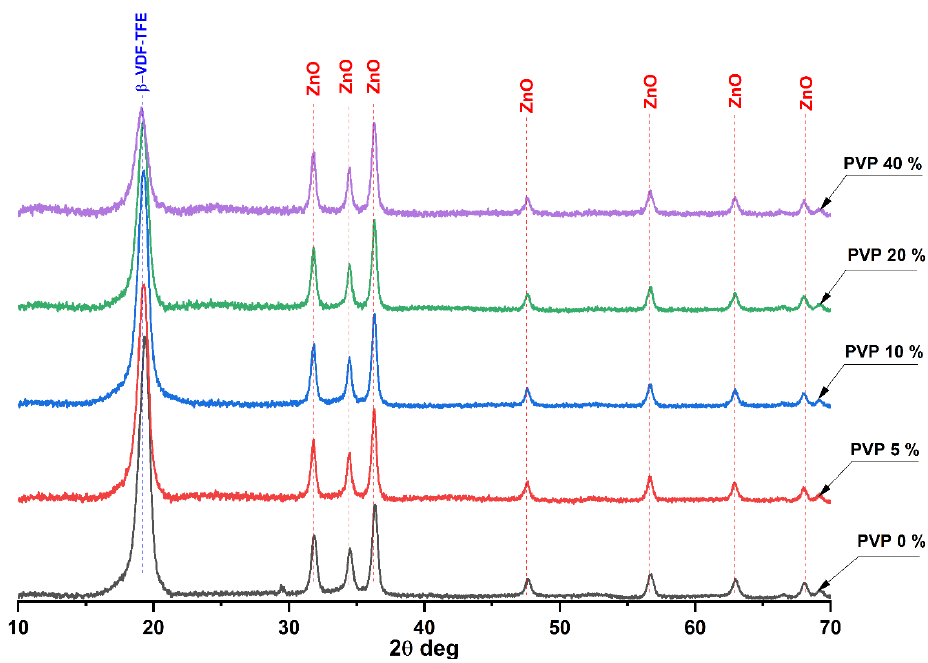
Figure 3. XRD patterns of the VDF-TeFE/PVP/ZnO membranes with various PVP contents. On the diffractogram of the PVP-free membrane several intensive reflexes were ob- served. The most intensive one at 19.3° corresponds to the most electrically active ferroe- lectric β -phase of the VDF-TeFE copolymer formed by macromolecules in the TTT confor- mation. The reflexes at 31.7°, 34.4°, 36.3°, 47.6°, 56.7°, 62.9°, and 68.0° correspond to wurtz-